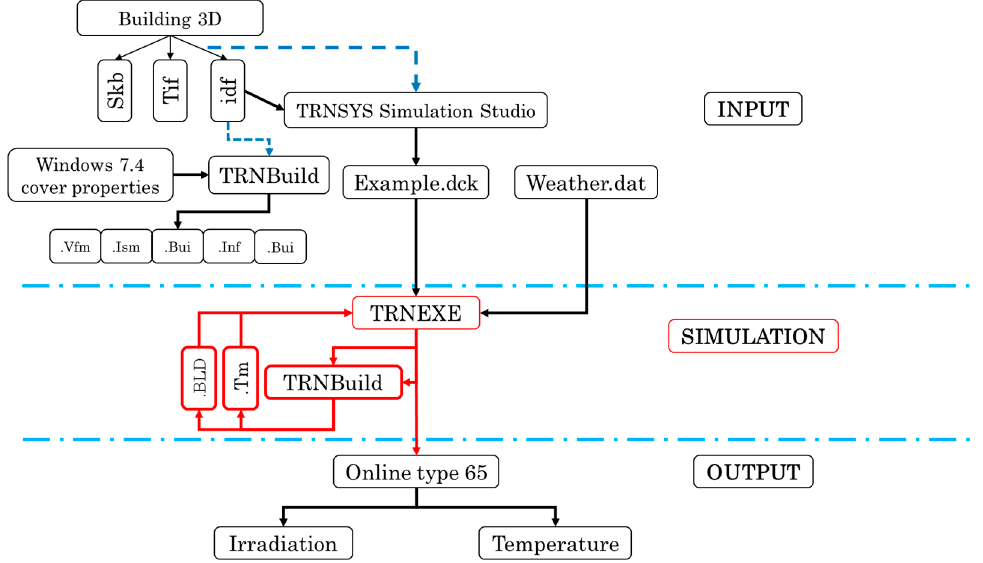
Figure 5. Dynamic building simulation Diagram in TRNSYS.